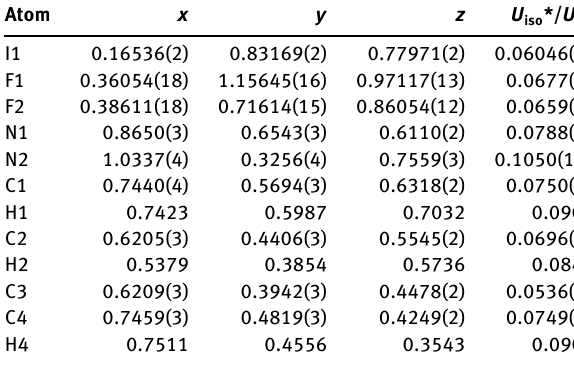
Table 2: Fractional atomic coordinates and isotropic or equivalent isotropic displacement parameters (Å 2